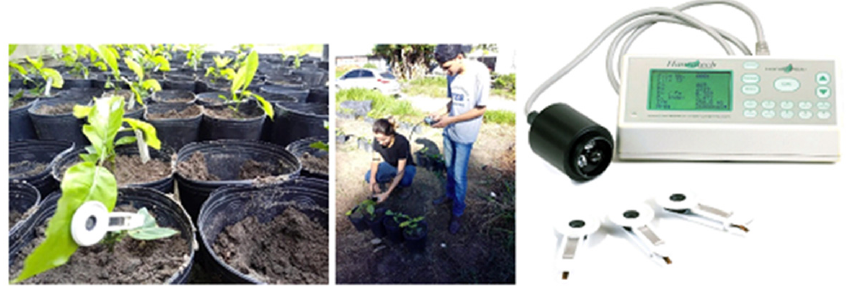
Figure 9. Schematic diagram of clip positioning and reading positioning with fluorometer, reading moment and detail Handy-PEA ® equipment.